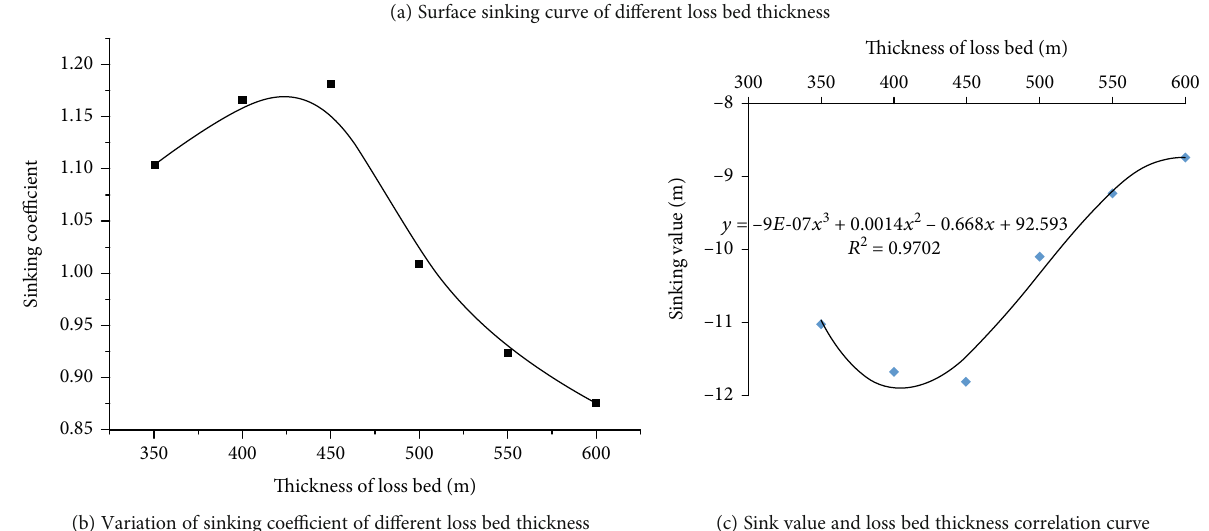
(c) Sink value and loss bed thickness correlation curve Figure 13: Di ff erent loss bed thickness a ff ects